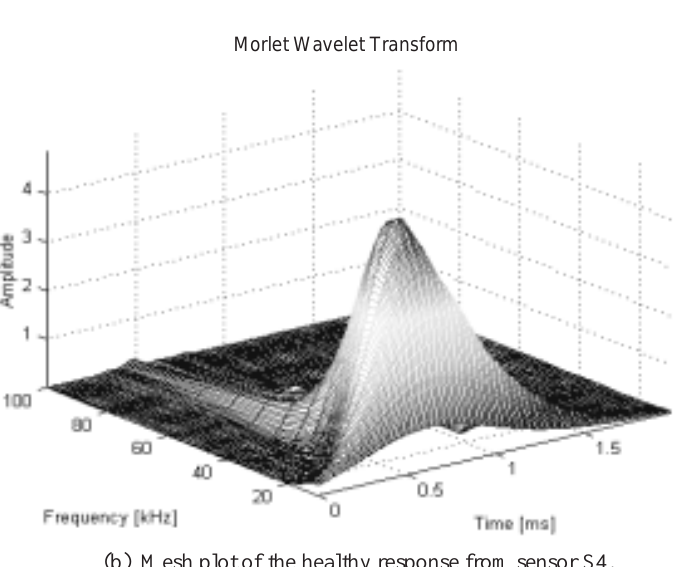
Fig. 20. Wavelet plots of the response of the healthy leg of the flexbeam. (a) Contour plot of the damage response from sensor S2. (b) Mesh plot of the damaged response from sensor